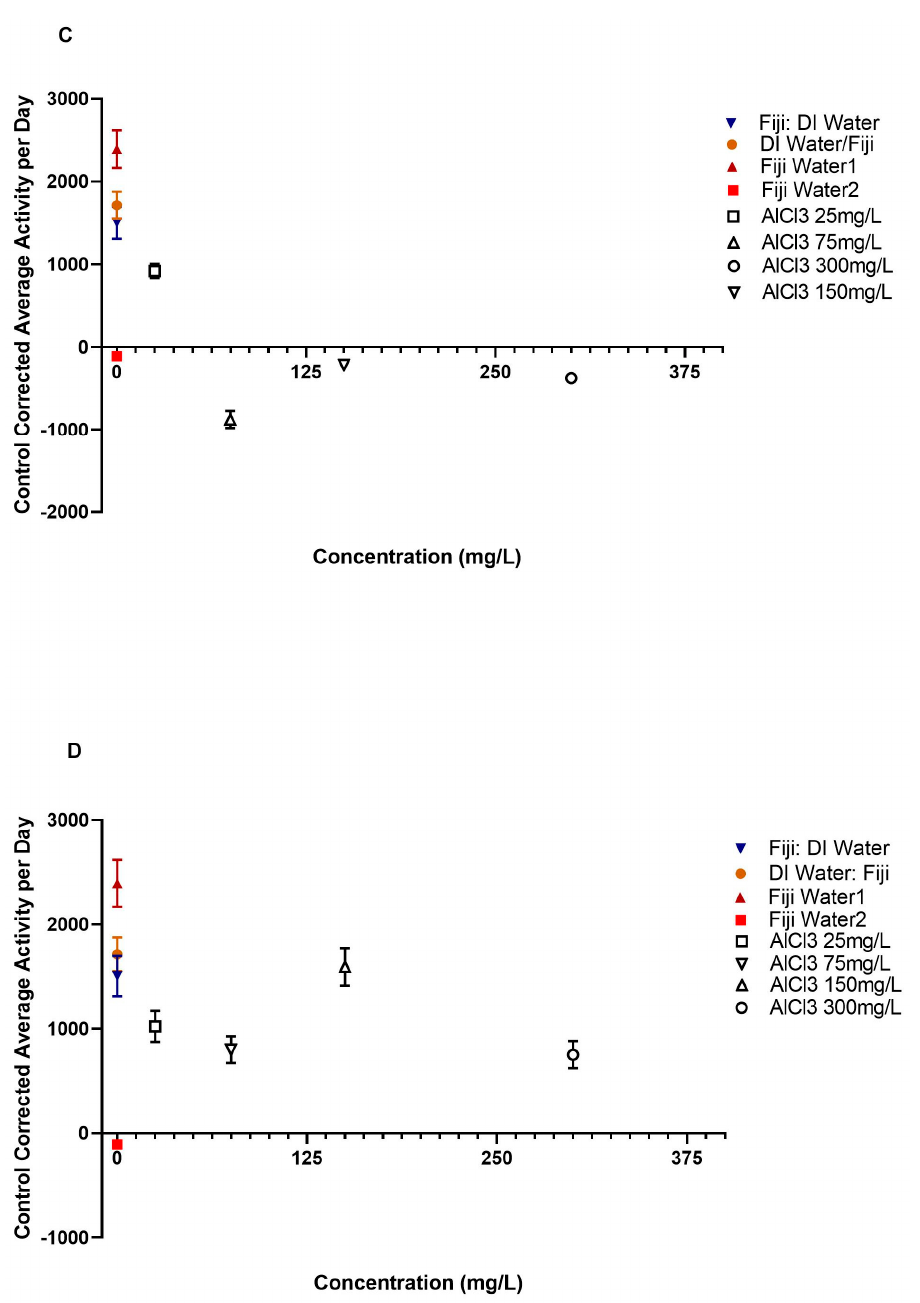
Figure 2. The overall daily activity for honey bees by first exposure group with standard error of the mean bars. The zero line represents the baseline control data. ( A ) Activity for AlCl3 → Fiji groups compared to Fiji water, DI water → Fiji, and Fiji → DI water control group bees. ( B ) Activity for AlCl3 → DI water groups compared to respective Fiji water, DI water → Fiji, and Fiji → DI water control group bees. ( C ) Activity for DI water → AlCl3 groups compared to respective Fiji water, DI water → Fiji, and Fiji → DI water control group bees. ( D ) Activity for Fiji → AlCl3 compared to respective Fiji water, DI water → Fiji, and Fiji → DI water control group bees.